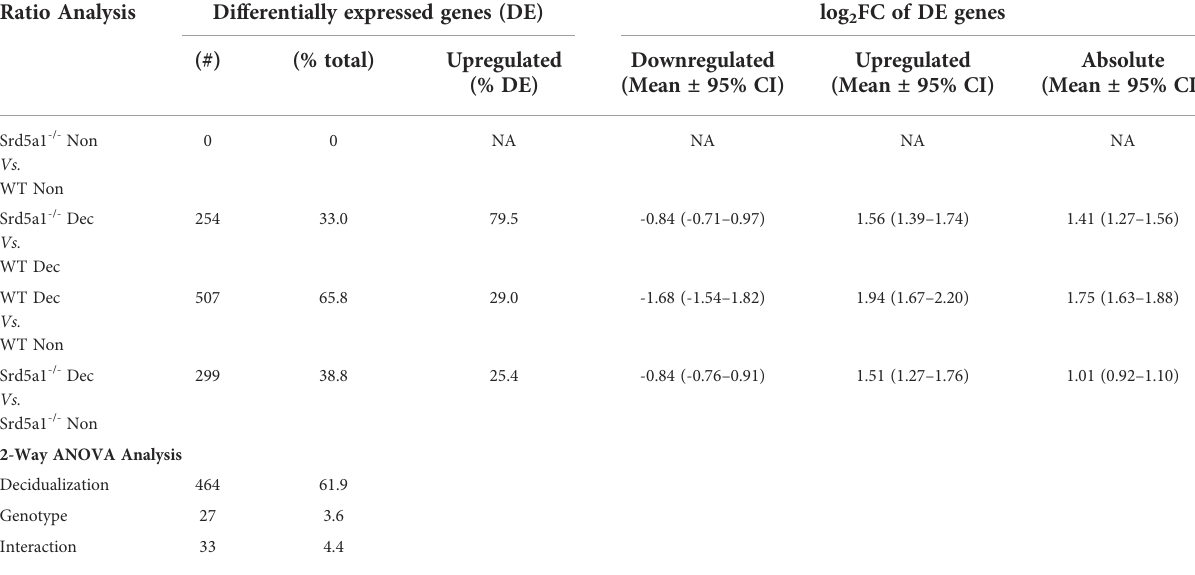
TABLE 1 Summary of differentially expressed genes using ratio analysis and 2-Way ANOVA analysis of Pancancer Pathways Nanostring panel. Ratio